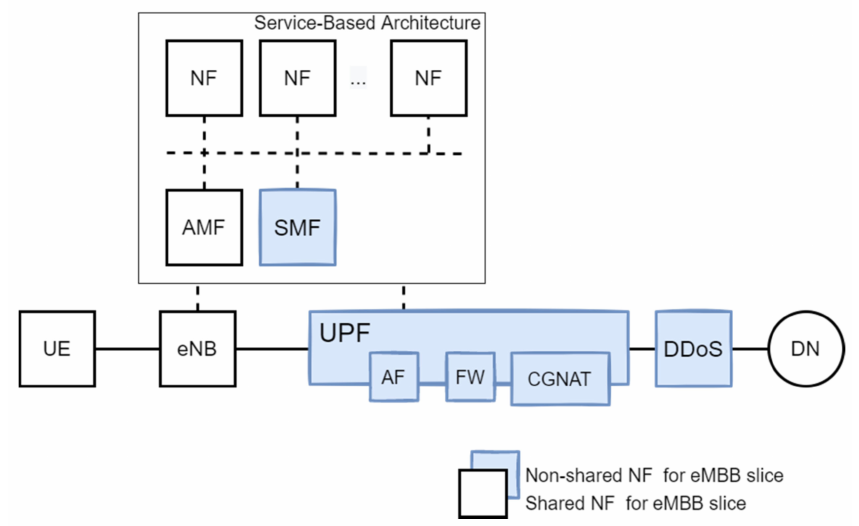
Figure 12. Network Slice with Secure Internet